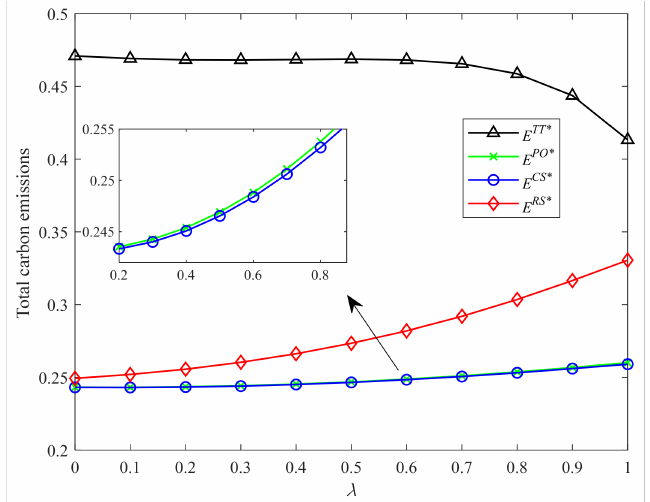
Figure 6. Comparison of total carbon emissions with different λ